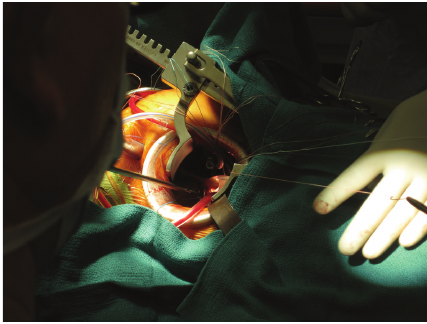
Figure 1: Level 2 minimally invasive approach (4–6cm incision).